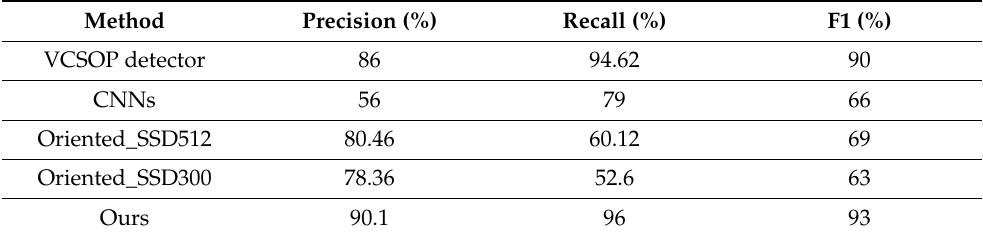
Table 3. Results of different methods on the VEDAI512 data